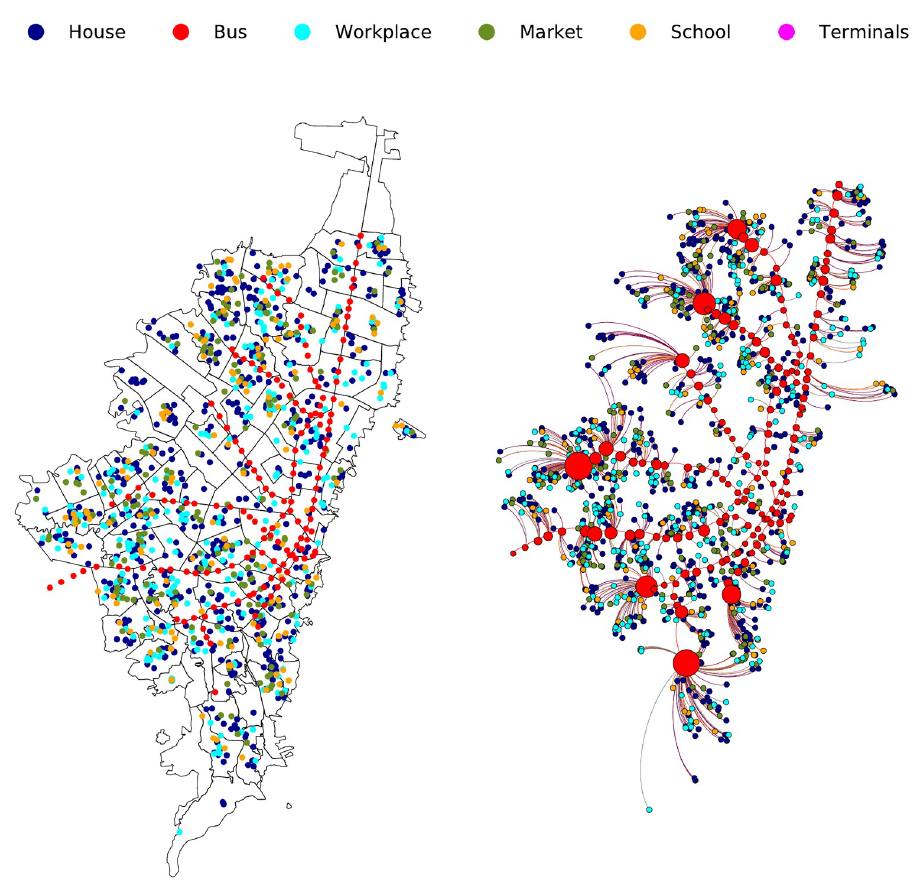
Fig 2. Example of 1000 georeferenced places in Bogota´ (left) and it’s corresponding representation in the euclidean complex network (right).